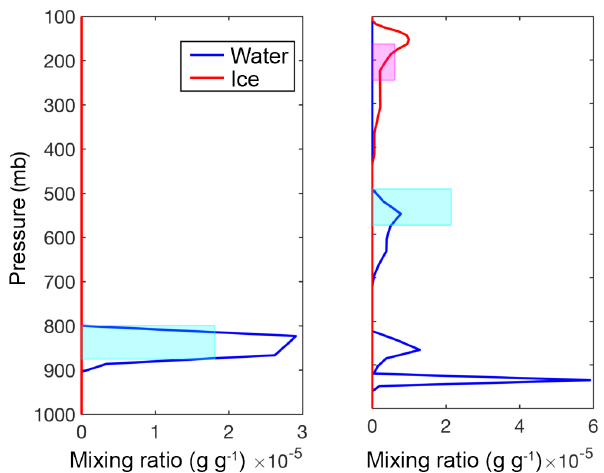
Figure 1. Example of cloud vertical profiles, reduced to one or two slabs. The red and blue curves come from the NWP model, while the cyan and magenta bars are the resulting locations (and loadings) for the